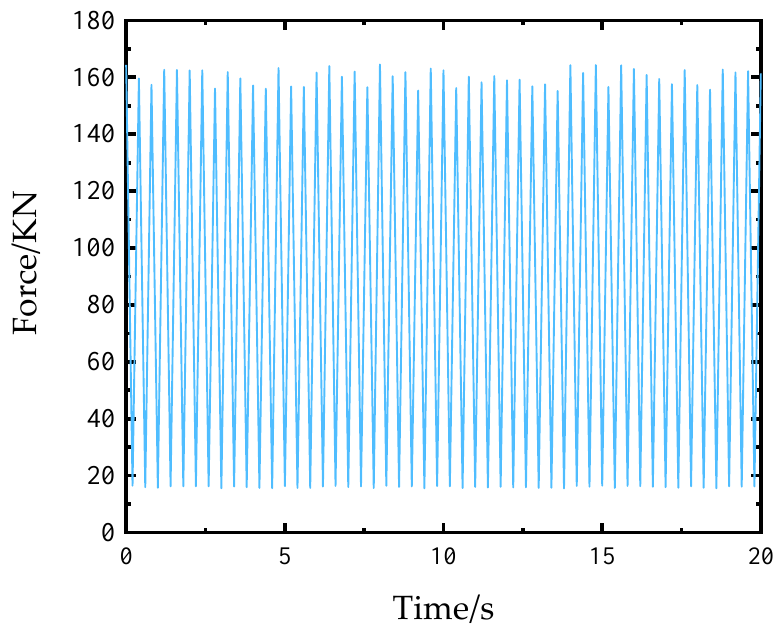
Figure 8. Forms of applied load.